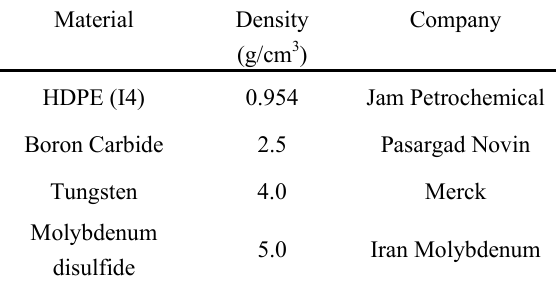
Table 1. Turbidity of Radiology Images of Lead, HDPE/